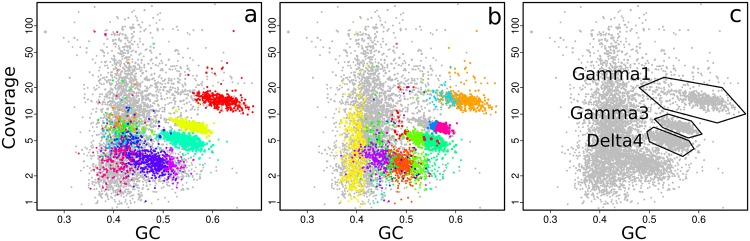
Coverage-GC plots of an O. algarvensis metagenome, illustrating overlays for visualizing multiple genome bins: (a) 11 genome bins produced by MetaBAT, each in a different color, (b) 20 genome bins produced by MetaWatt, each in a different color, (c) boundaries of manually defined bins that were interactively selected on the plot, corresponding approximately to the indicated symbiont genomes. Colors in (a) and (b) are arbitrary.